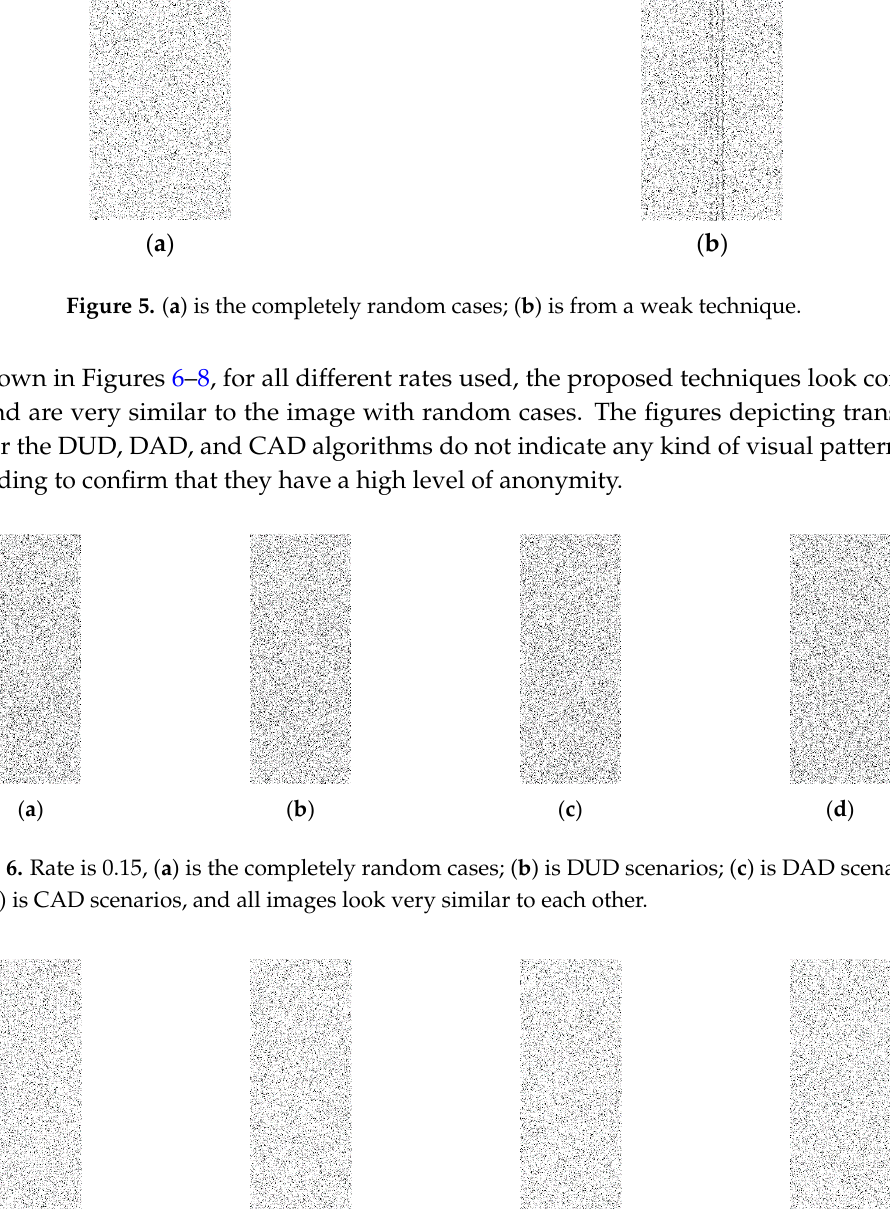
Figure 7. Rate is 0.1, ( a ) is the completely random scenarios; ( b ) is DUD scenarios; ( c ) is DAD scenarios and ( d ) is CAD scenarios, and all images look very similar to each other.